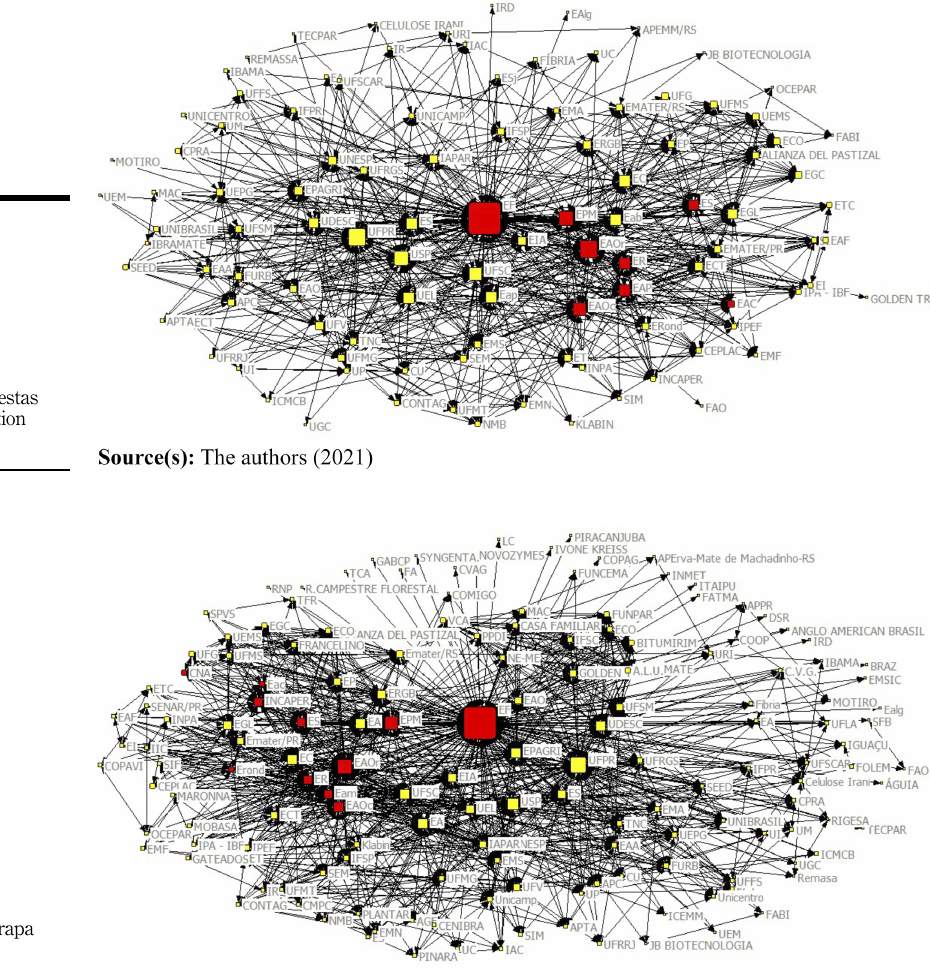
Figure 3. Network Embrapa Forestas open